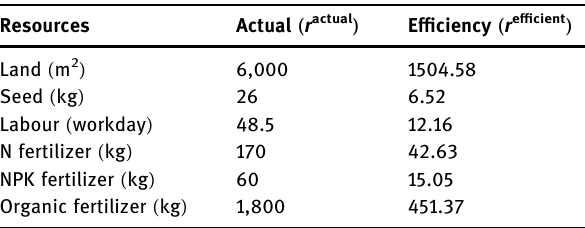
Table 7: Actual and e ffi cient agricultural resource use on a farm in